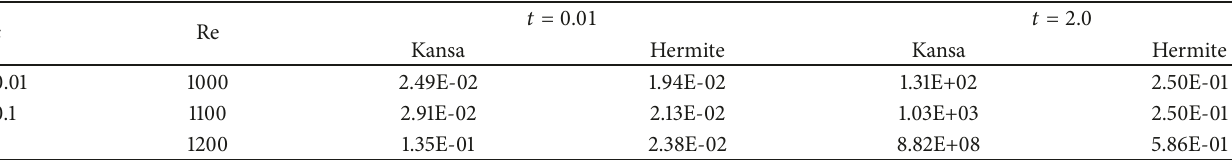
Table 9: Averaged 𝐿 ∞ - error obtained with 𝑁 = 100, Δ𝑡 = 0.001 for high Reynolds